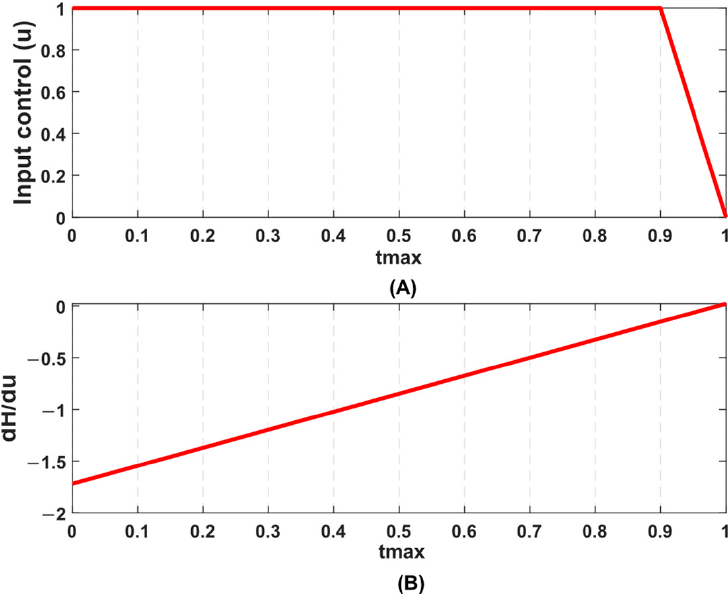
Figure 7. ( A ) States and ( B ) co-states for the whole system.